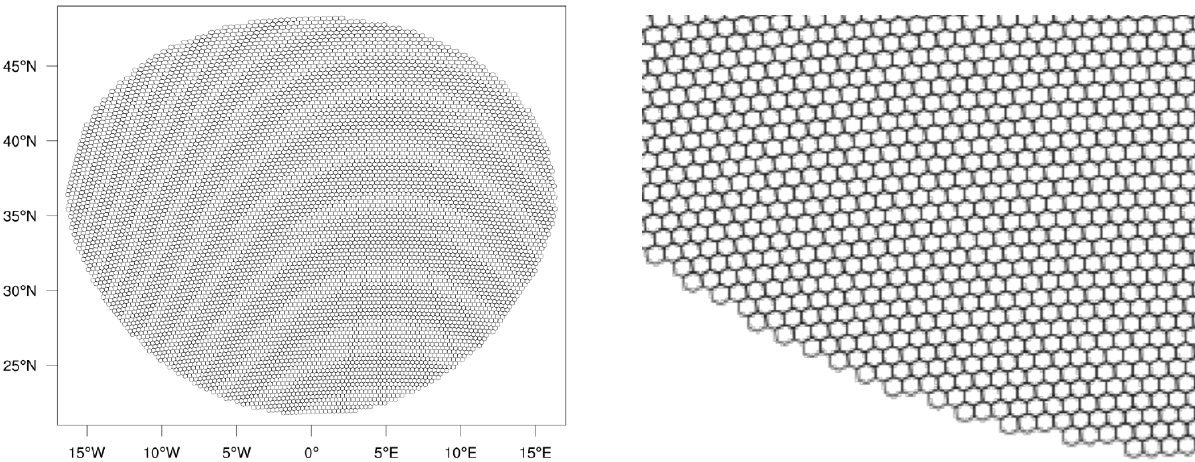
Figure 1. The 32km grid used for the wind-driven gyre test case and a zoom-in on a portion of that mesh.